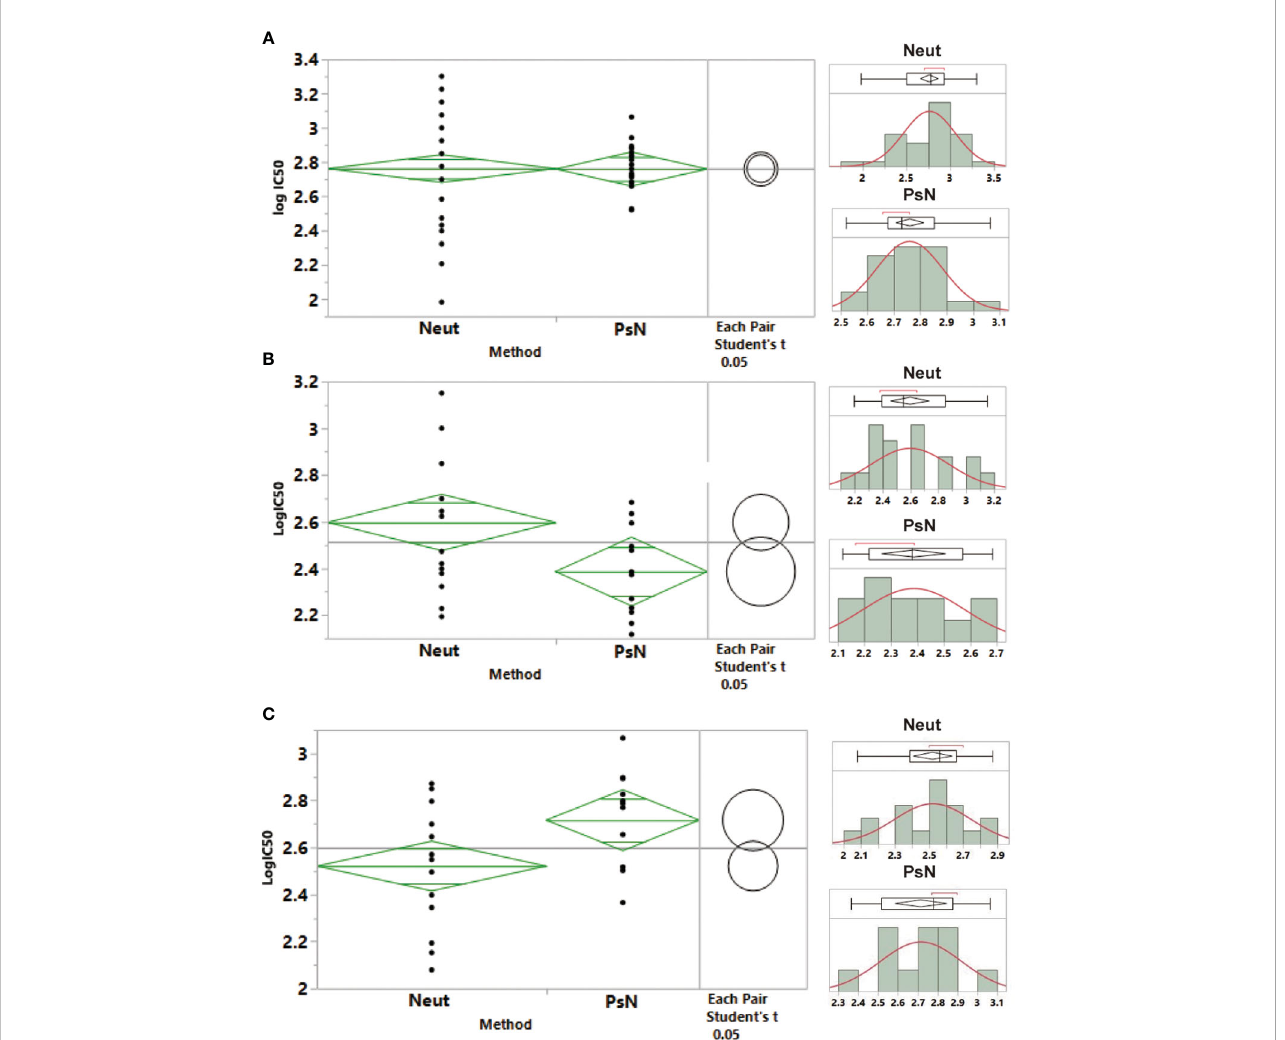
FIGURE 4 Statistical analysis for the neutralizing antibody potencies of samples 66 – 99, 33, and 22, and calibration to the international standard. (A) Samples 66 – 99; (B) Sample 33; (C) Sample 22. A normal distribution analysis of the neutralizing antibody potencies of samples 66 – 99, 33, and 22 was carried out. One- way analysis of variance was used to analyze the variance between the live virus neutralization assay (Neut) and pseudovirus neutralization assay